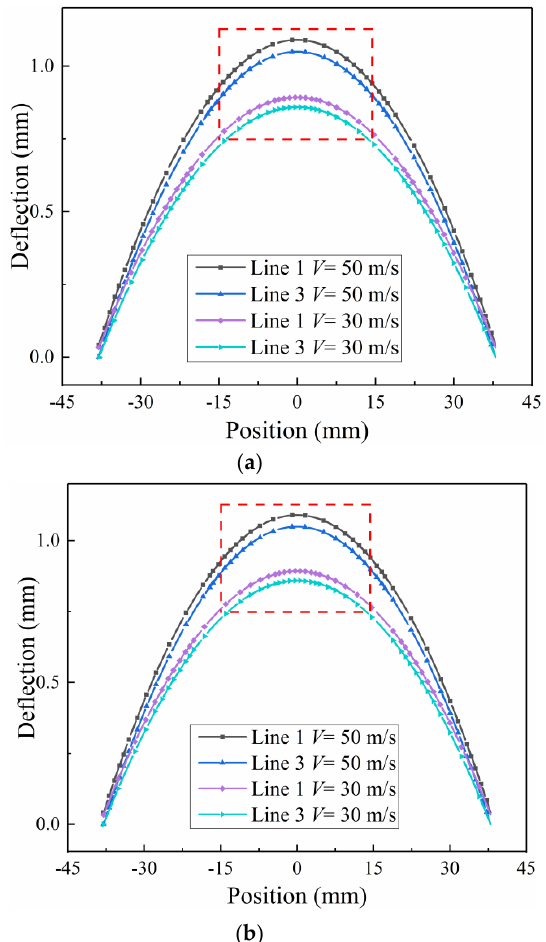
Figure 12. Coordinate system on the Almen strip and definition of the four lines. ( a ) Calculated deflections along the X or Y direction for lines 1, 2, 3 and 4. ( b ) The detailed view shows the arc height